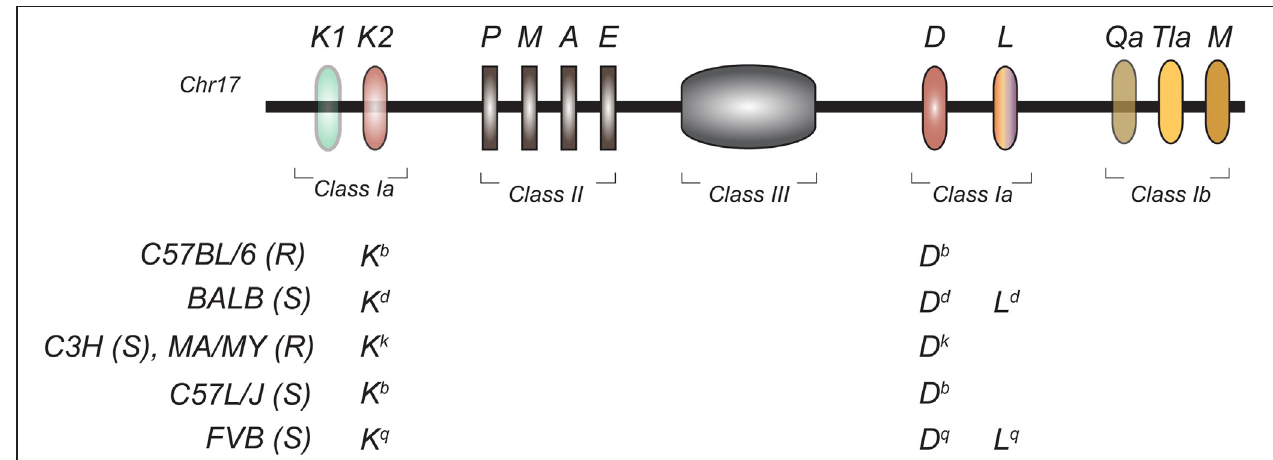
FIGURE 3 | Genomic organization of the mouse MHC region in inbred mouse strains. The H2 is located on chromosome 17 and encodes for classical class I (Ia) and non-classical class I (Ib), class II, and class III